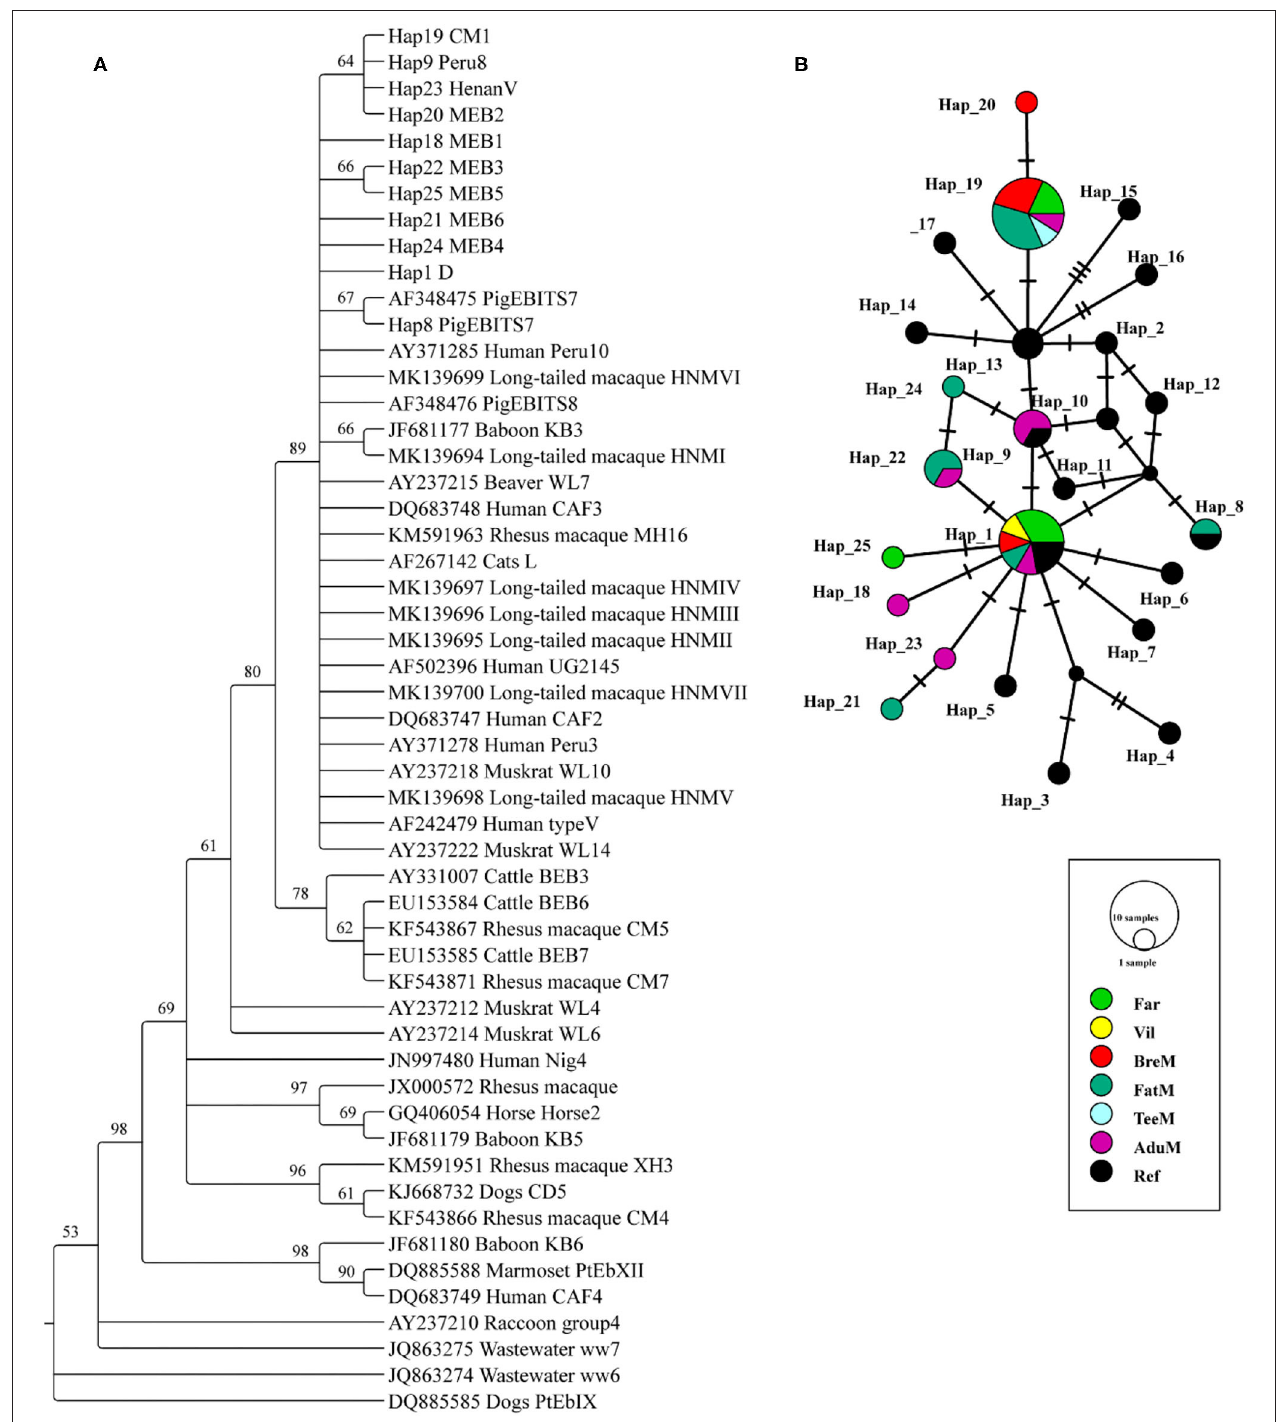
FIGURE 1 | Phylogenetic tree constructed using neighbor-joining (NJ) method and haplotype analysis network of Enterocytozoon bieneusi based on ∼ 243 bp sequence of the internal transcribed spacer 2 ( ITS2 ) region. (A) The phylogenetic analysis tree was constructed using the Kimura two-parameter model with 100 bootstrap replications. Eleven haplotypes were used in tree construction. (B) All the 31 sequences in this study and 19 published sequences in group 1 cluster were used to generate haplotype data. The network was constructed using TCS Network algorithm. Various colors represent different groups and the sizes of the circle represent the numbers of haplotypes. Far, facility workers; Vil, villagers; BreM, breeding macaques; FatM, fattening macaques; TeeM, teenage macaques; AduM, adult male macaques; Ref, reference published sequences.